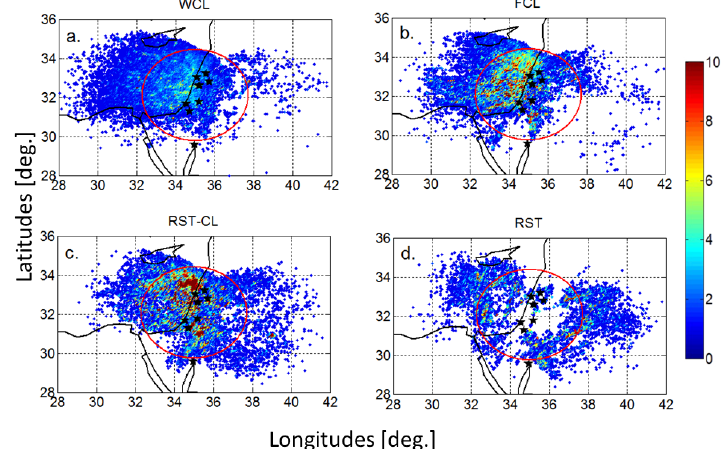
Figure 5. Strokes density according to the four synoptic systems (25km − 2 day − 1 ). To highlight spatial features and to compare between all systems, a similar color bar is used (maximum values are 37 in WCL, 54 in FCL, 33 in RST and 131 (25km − 2 day − 1 ) in RST-CL). Red circles mark the study region. Black stars mark the location of the ILLS detectors. The average density of strokes in the 250km radius is 1.1 (WCL), 1.3 (FCL), 1.4 (RST-CL) and 1.1km − 2 day − 1 (RST).